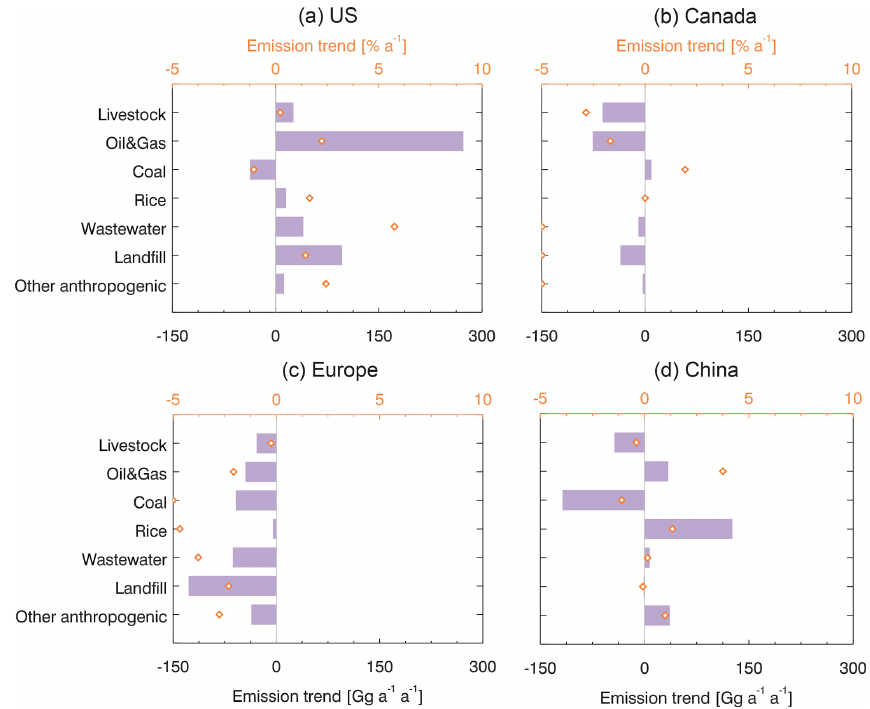
Figure 12. Optimization by sector of regional anthropogenic methane emission trends in 2010–2017. Bars and diamonds represent trends in gigagrams per annum per annum (Gga − 1 a − 1 , bottom axis) and percent per annum (%a − 1 , top axis) over the 2010–2017 period from the GOSAT + in situ joint